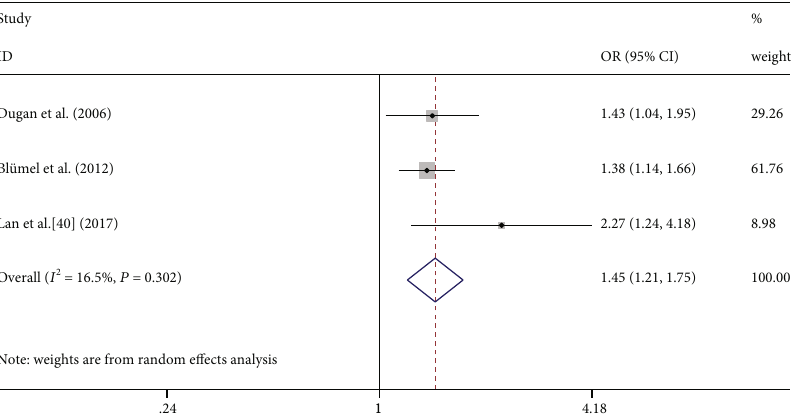
Figure 5: Meta-analysis of moderate/severe MSP between premenopausal and perimenopausal women. Three studies were included in the analysis. OR (95% CI): odds ratio (95% con fi dence